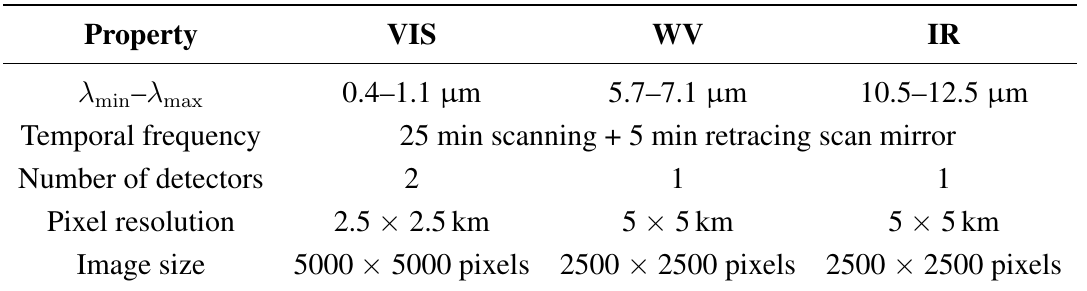
Table 1. Characteristics of the three MVIRI